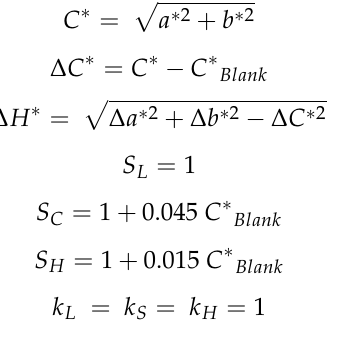
Figure 3. Preliminary naked-eye tests for lysozyme concentrations ranging from 143.1 to 0.71 µg/mL.